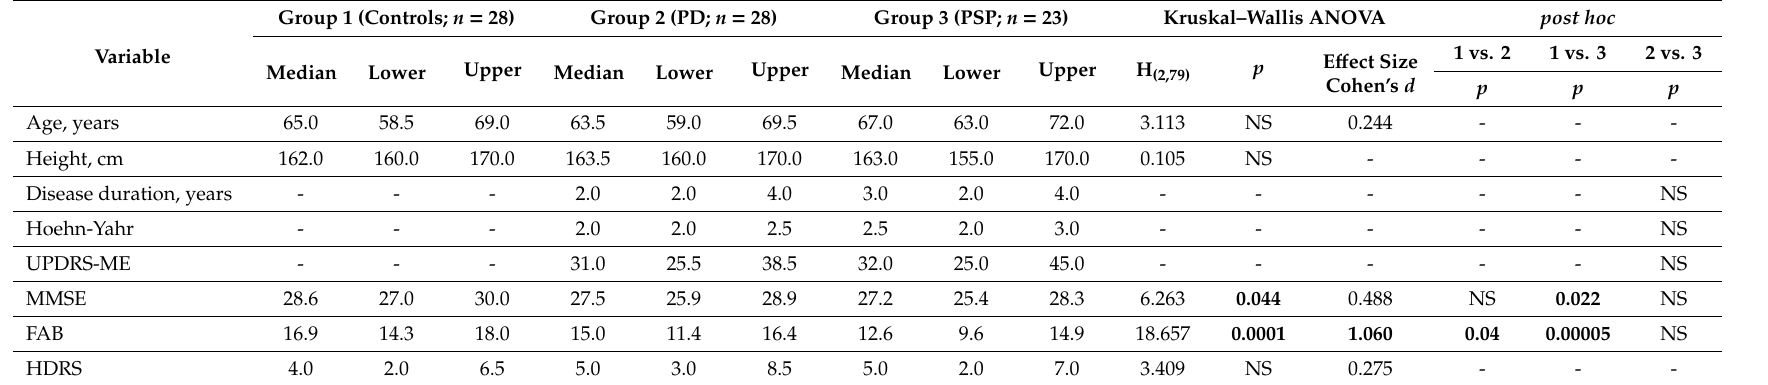
Table 1. Clinical-demographic and neuropsychological features of the three groups.